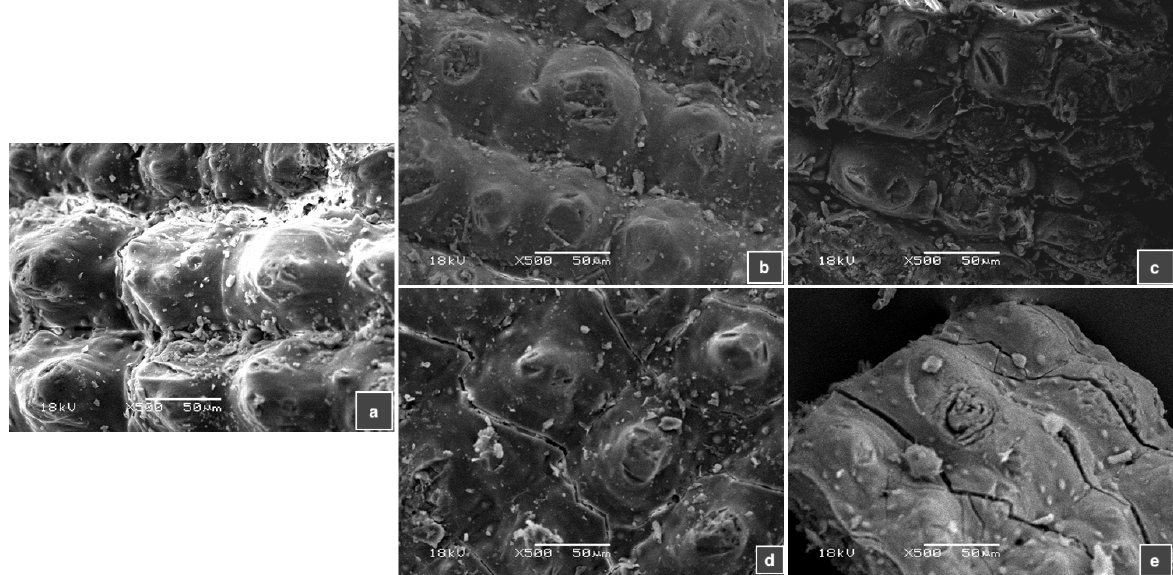
Figure 10. SEM comparison of rice hull samples before and after treatment with IL (600 times magnification). (a) Untreated rice hull outer surface, (b) treatment at 100 °C, 2 h, using [bmim][Ac]; (c) treatment at 100 °C, 6 h using [bmim][Ac]; (d) treatment at 100 °C, 2 h, using [bmim][Cl]; (e) treatment at 100 °C, 6 h, using